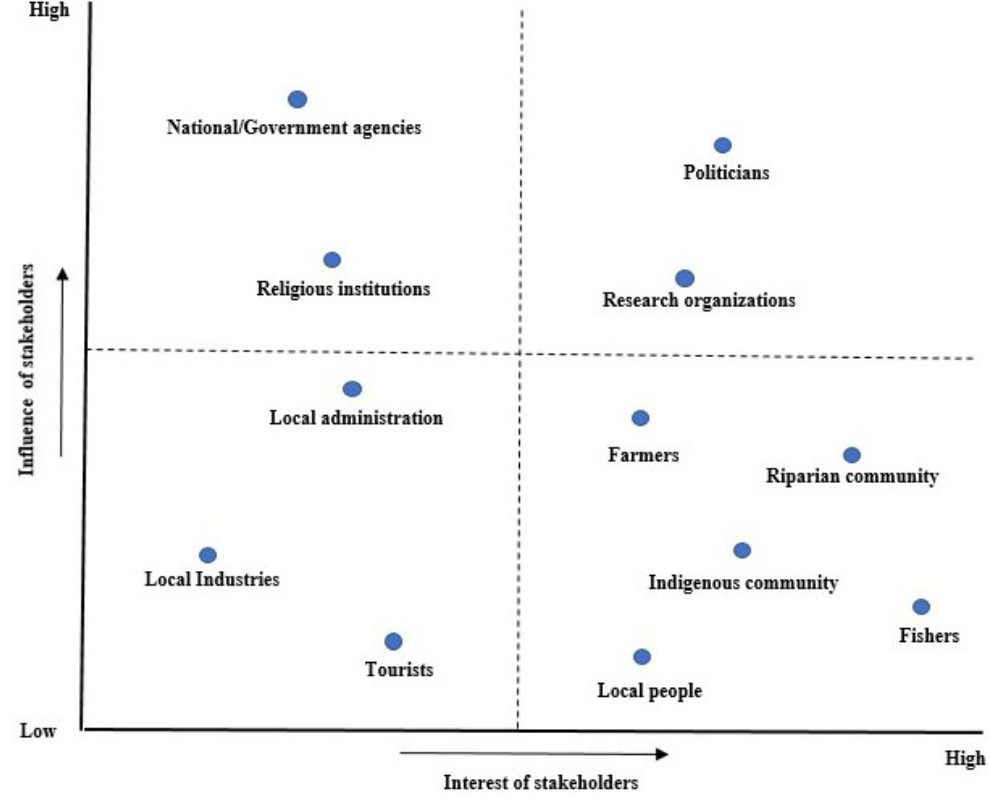
Figure 4. The influence–interest matrix of riverine